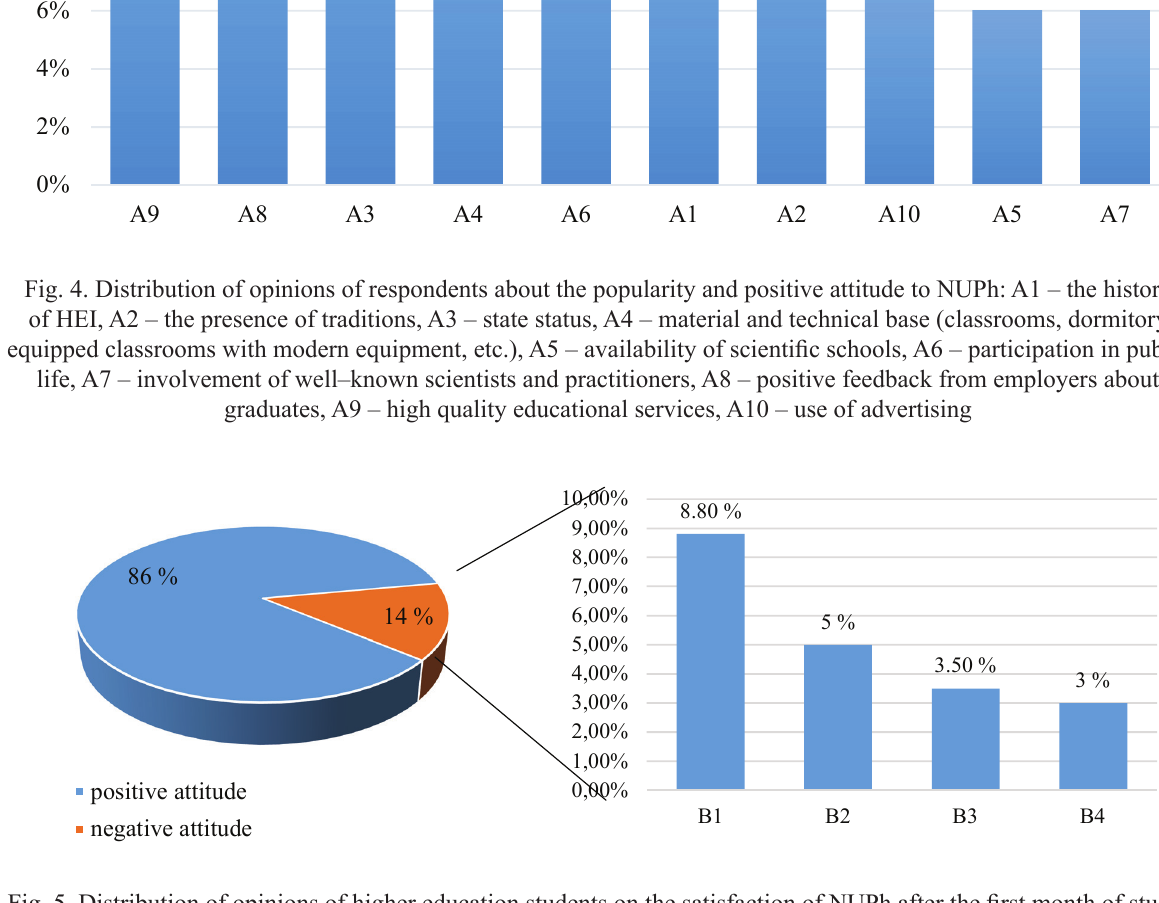
Fig. 5. Distribution of opinions of higher education students on the satisfaction of NUPh after the fi rst month of study: B1 – diffi culties in adapting to student life, B2 – diffi culties in adapting to the study schedule, B3 – complaints about living conditions in the dormitory, B4 – dissatisfaction with meaningful aspects of